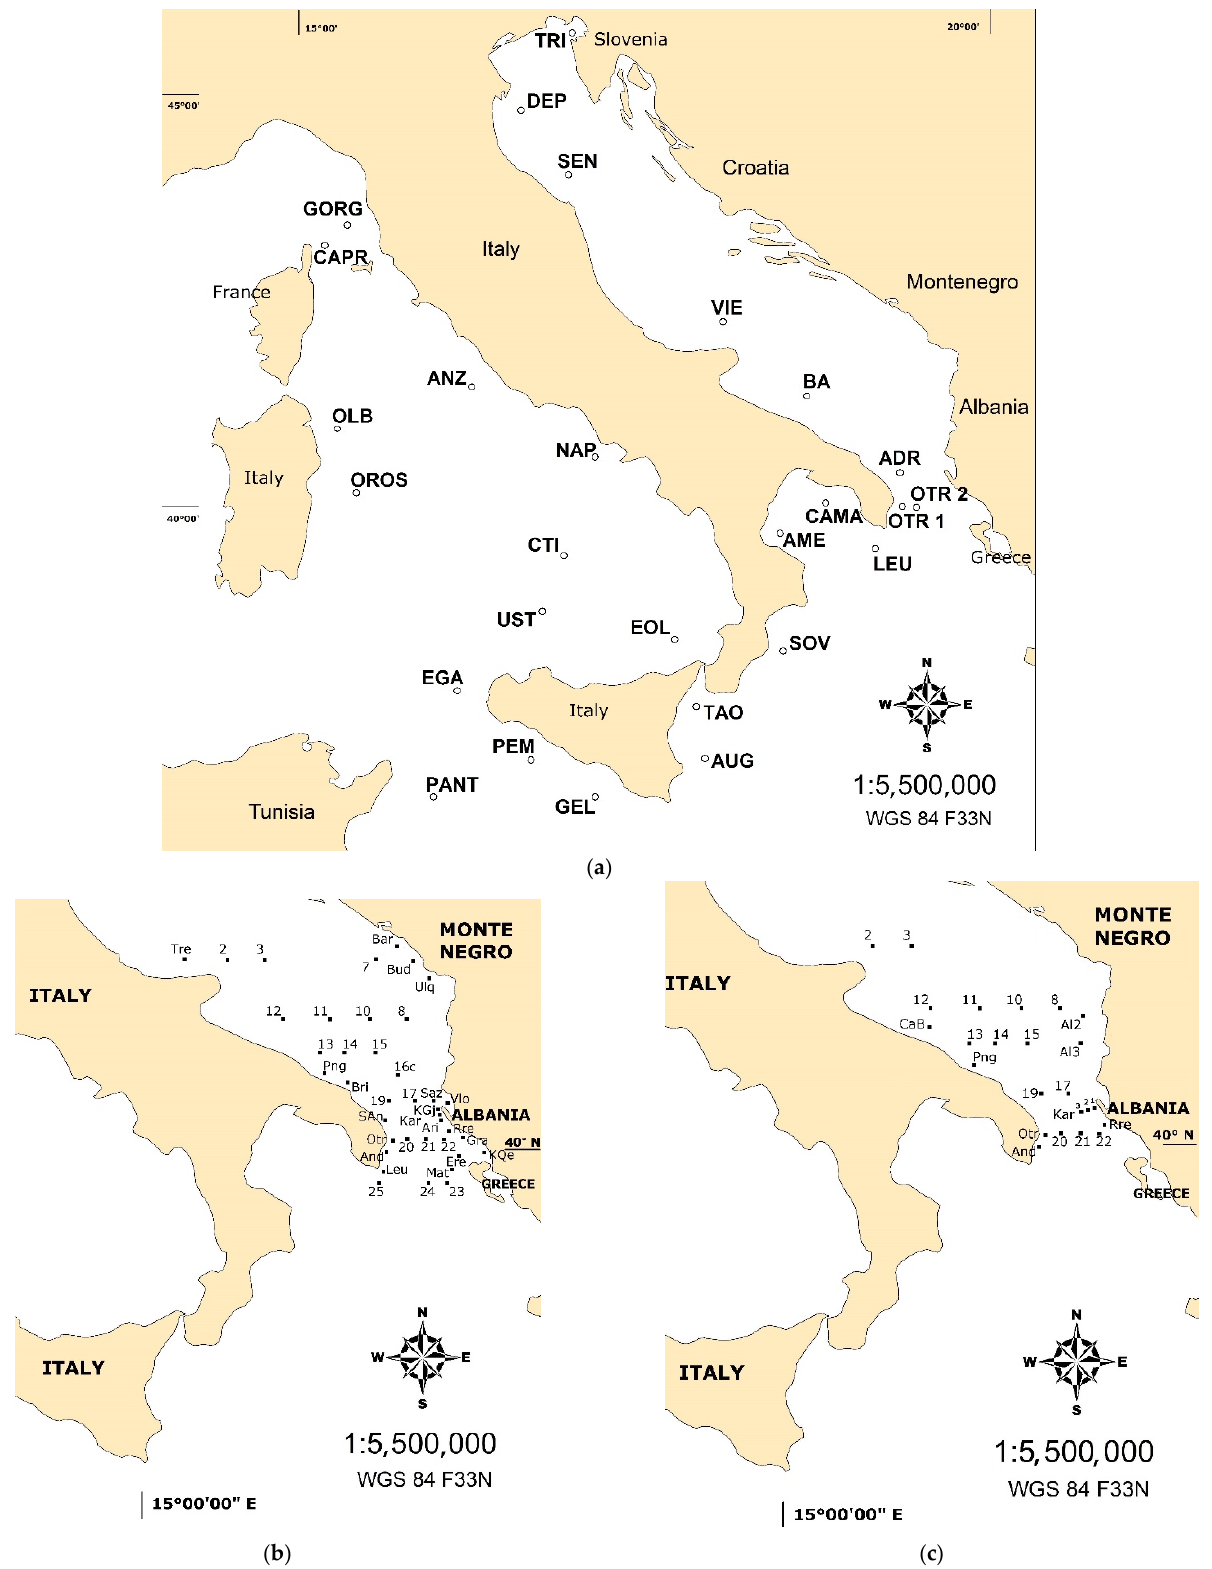
Figure 1. ( a ) Map of the study area showing the location, 27 sampling stations in the Italian Seas (2017); and maps of the South Adriatic where two cruises were carried out in 2013 (39 stations) ( b ), and 2015 (24 stations) ( c ). Due to the methodological correspondence of sample collection (see below), the re- sults of the 2017 cruise were compared with data of two preceding cruises limited to the